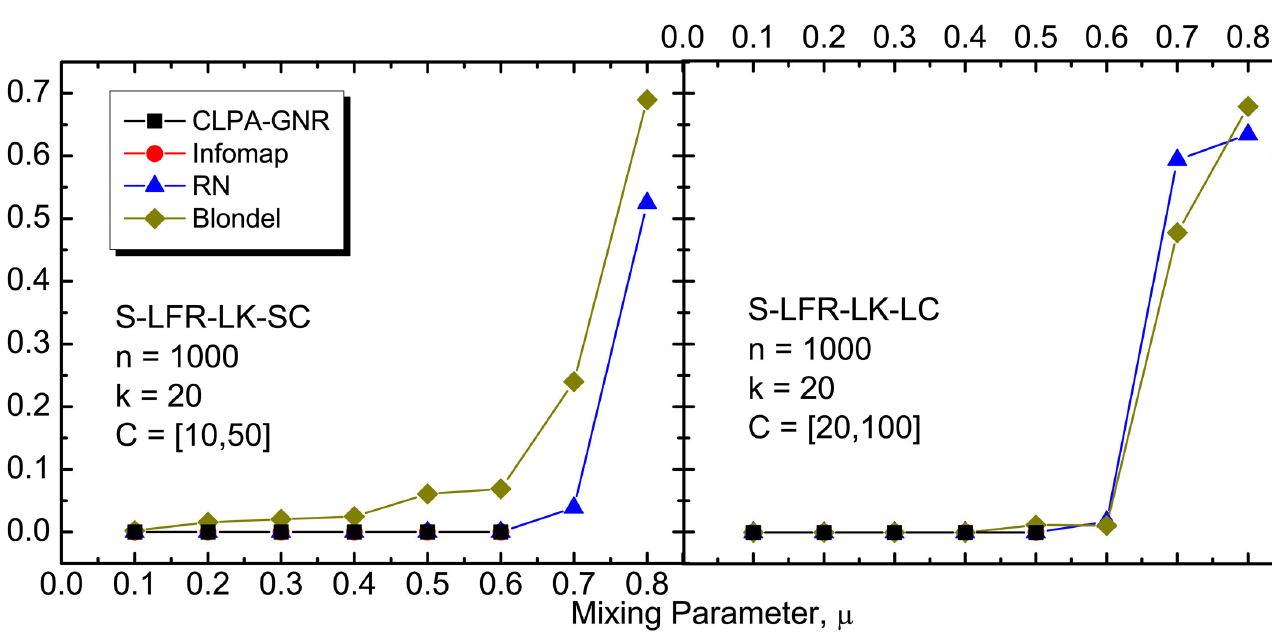
Fig 7. The NVI comparison on undirected and unweighted small LFR benchmark networks with large average